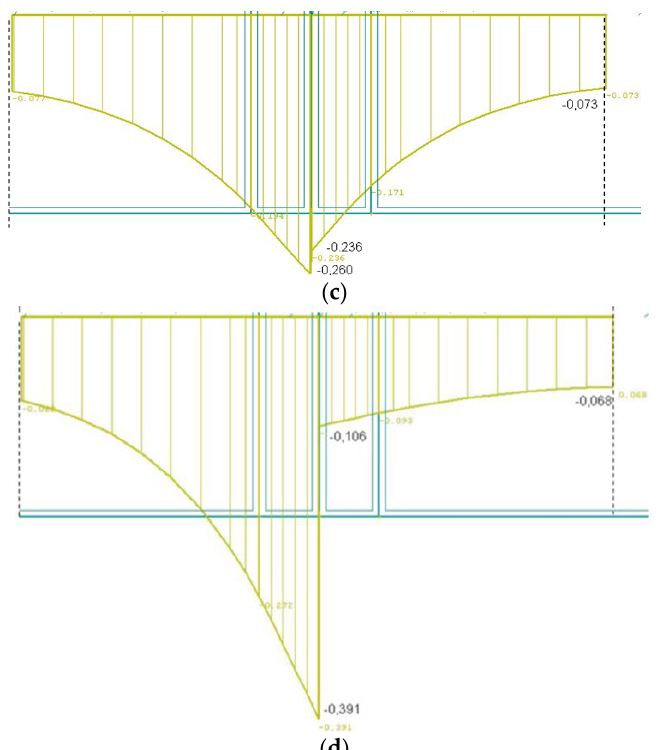
Figure 9. Comparison of deflection on transversal joint of concrete pavement at different degrees of interaction: ( a ) load diagram of transverse joint; ( b ) stiff subbase/good interaction; ( c ) soft subbase/good interaction and ( d ) soft subbase/poor interaction.